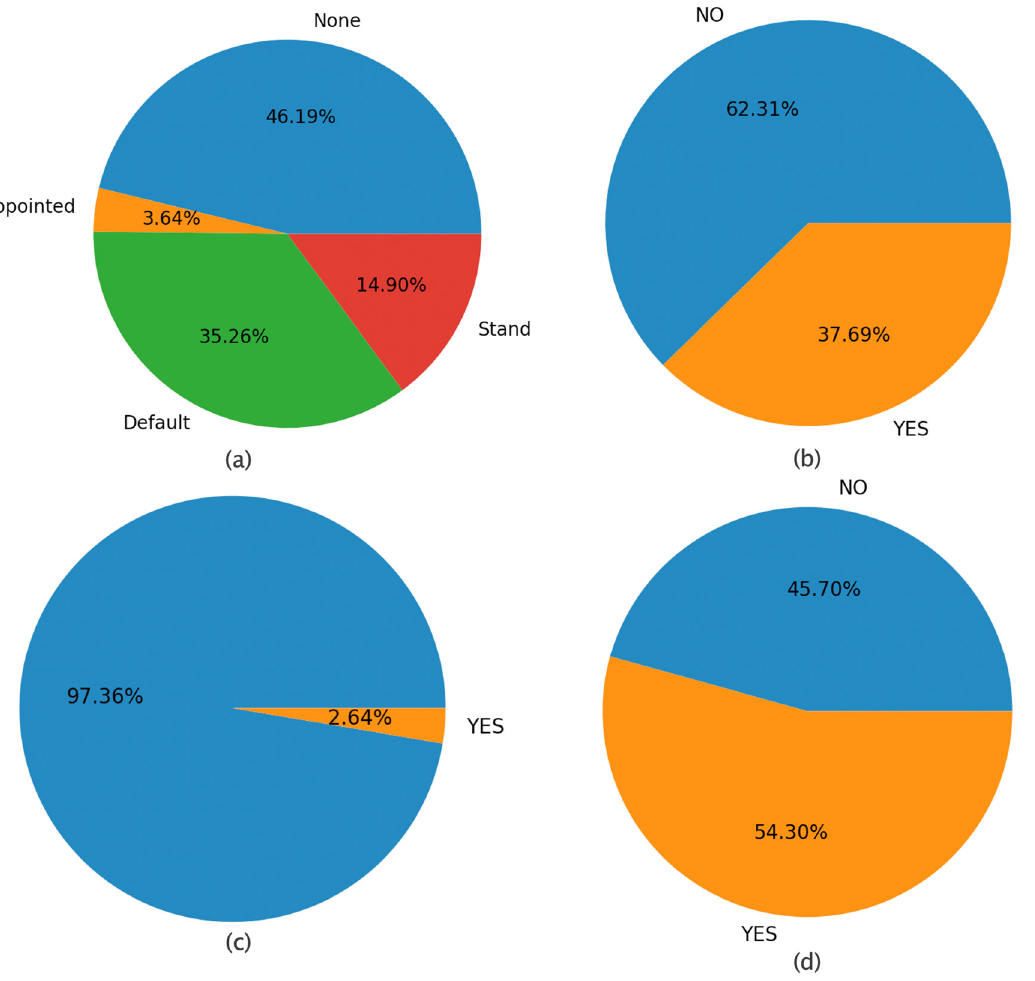
Figure 12. Distribution of the 604 complete frames in the equivalence class of the string “806” in all the 90 eligible attempts over each set of robot actions regarding four robot modalities, namely ( a ) Animation, ( b ) Sound, ( c ) LEDs and ( d )